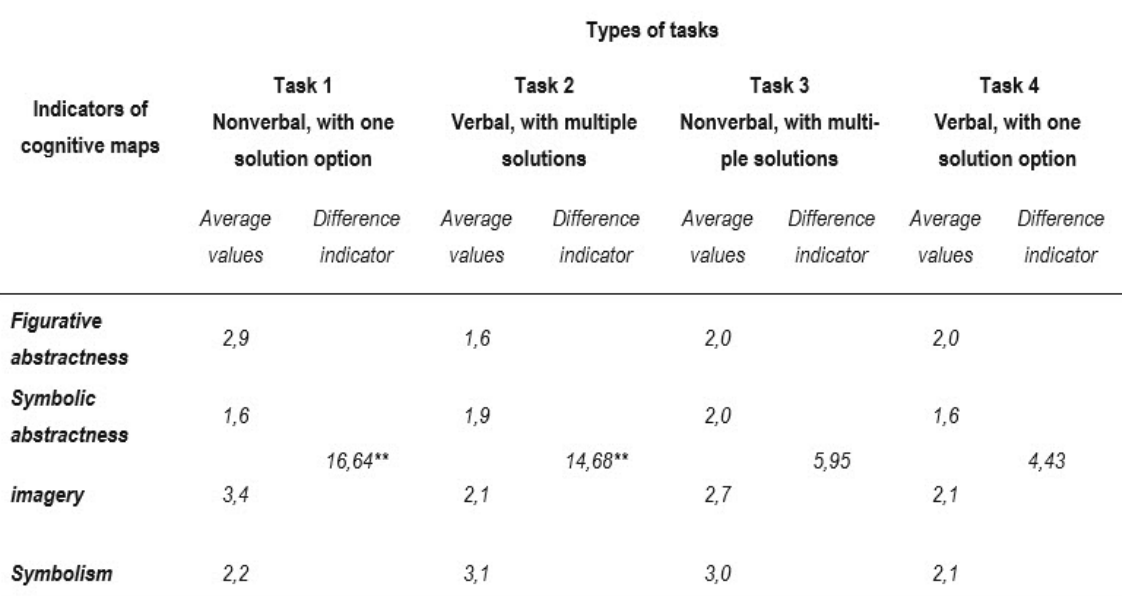
Differences between all indicators of cognitive maps performed without time constraints, based on the results of solving each individual type of